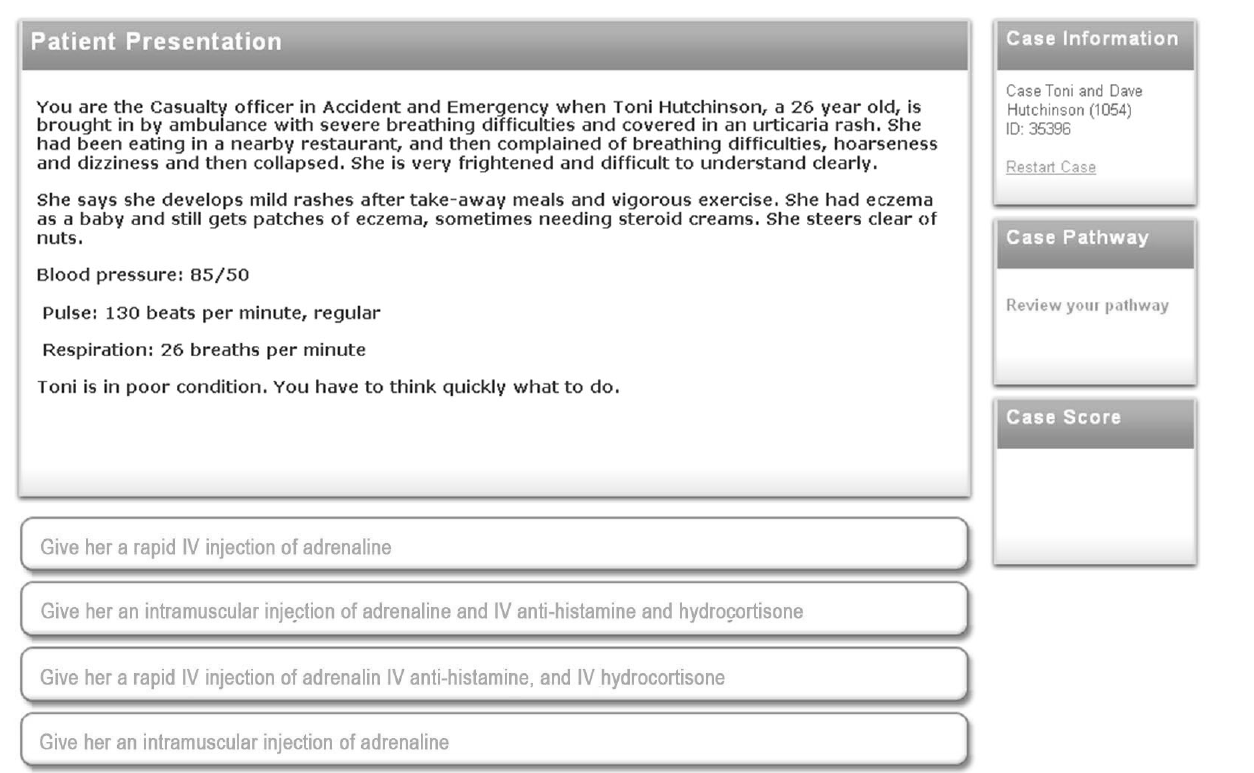
Figure 1. An example of a D-PBL page seen by the student PBL group at a decision point in a branching case in the authoring application OpenLabyrinth